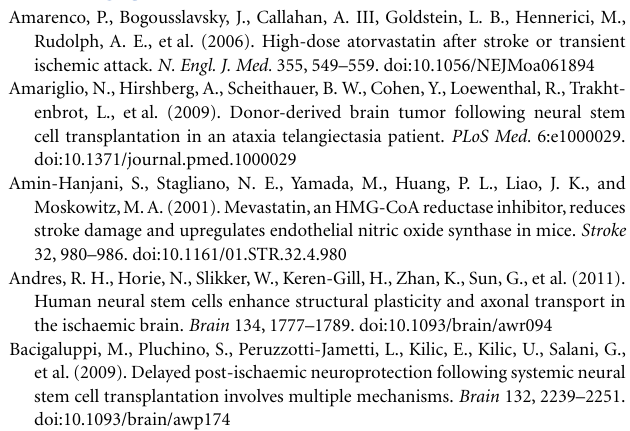
upregulation of HMG-CoA reductase in the contralesional hemisphere at 14 and 28 d.p.i. Data are mean values ± SD ( n = 3 independent blots/group). §§ p < 0.01/ § p < 0.05 compared with corresponding samples from sham-operated